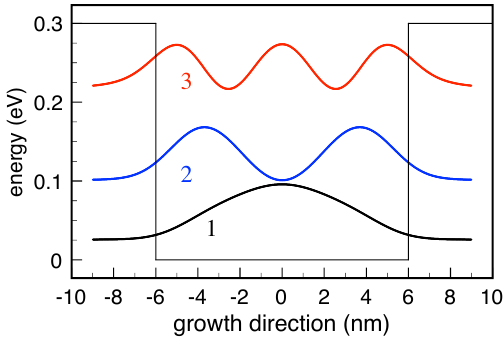
Figure 3. Conduction band profile along the growth direction for the prototypical GaAs/AlGaAs QW nanostructure considered in our simulated experiments. Energy levels of the three 1D bound states are shown, together with the corresponding squared envelope functions. Readapted from